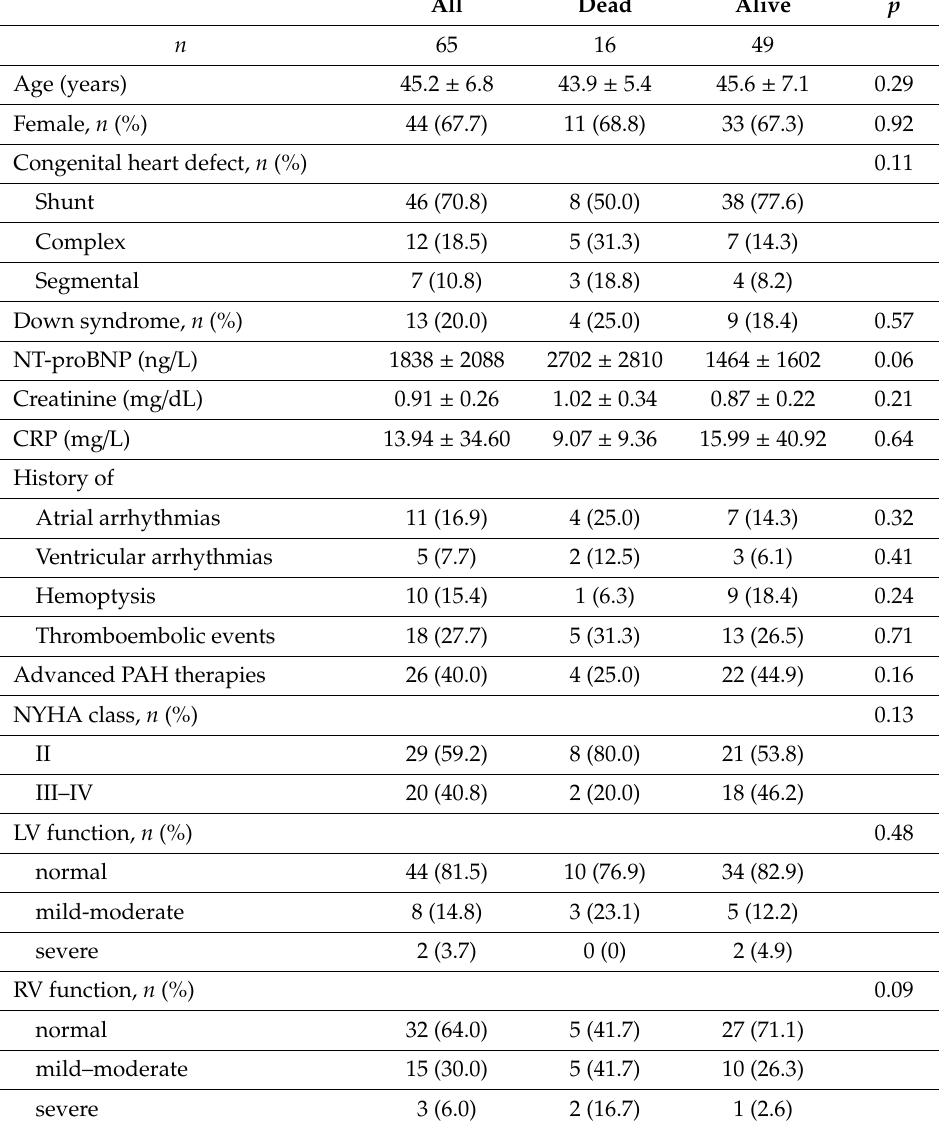
Table 1. Baseline